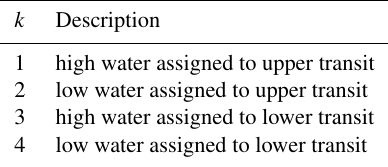
Table 1. The high and low waters are classified into four types (event index k ).